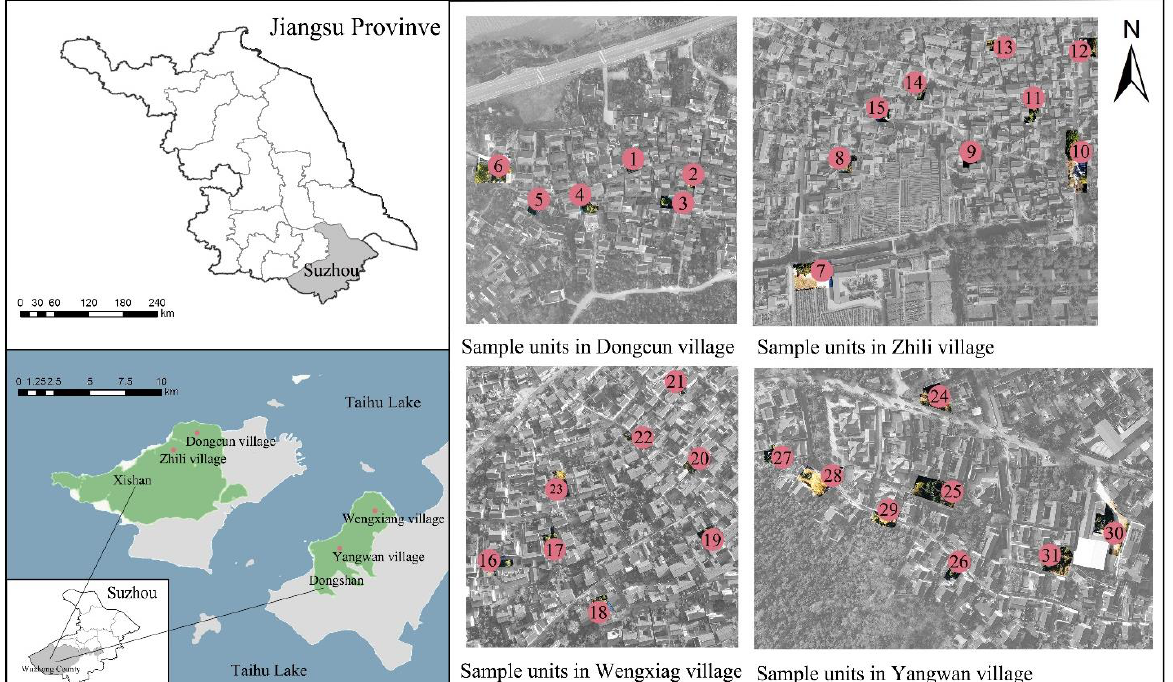
Figure 1. Thirty-one sample sites in four traditional